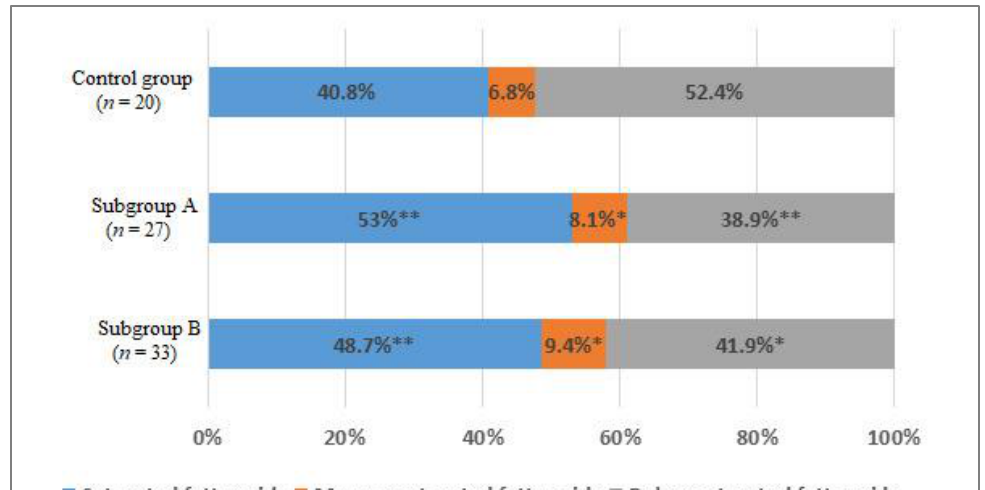
Figure 5. The percentage of saturated (SFAs), monounsaturated (MUFAs), and polyunsaturated fatty acids (PUFAs) of the total content of fatty acids in the blood of men without ischemic artery disease (Control group), men with ischemic artery disease and the presence of vulnerable atherosclerotic plaques in the coronary arteries (Subgroup A) and men with ischemic artery disease and the absence of vulnerable atherosclerotic plaques in the coronary arteries (Subgroup B), %. * — p < 0.05, ** — p < 0.01, p — the significance of difference in comparison with the Control group. Mainly due to an increase in the level of myristic acid by 1.3 and 1.8 times, respec- tively ( p < 0.05), and the level of palmitic acid by 1.6 and 1.3 times, respectively ( p < 0.05) (Table 3). Table 3. The content of FAs in the blood of men in Subgroups and in the Control group, Me (25%; 75%), mg/dL.